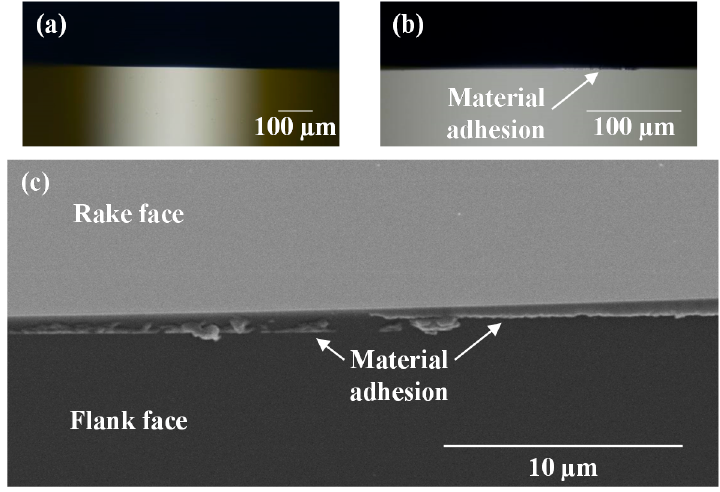
Figure 21. Tool observation results: ( a ) microscope image of tool edge before cutting; ( b ) microscope image and ( c ) Scanning electron microscope (SEM) image of the tool edge after cutting hexagonal microlens arrays on silicon.